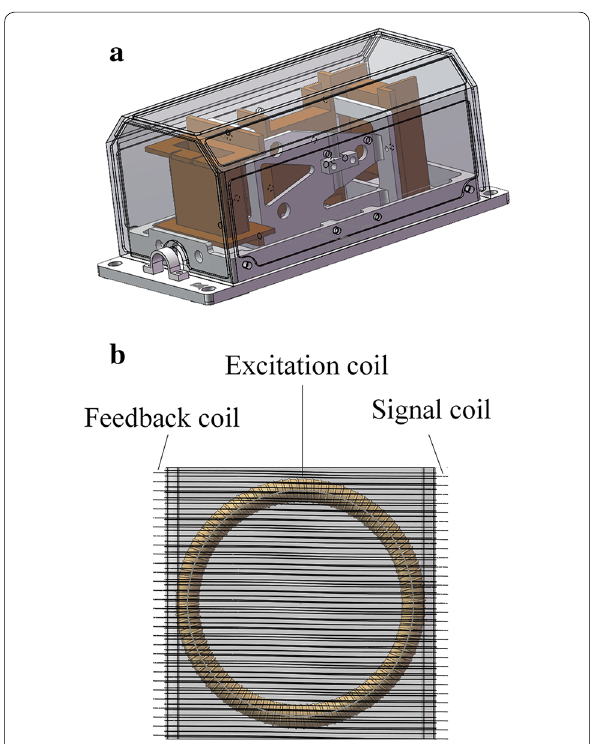
Fig. 3 FGM sensor configuration. a FGM sensor consists of three orthogonal components (shown as brown units); b each component consists of three coils: excitation coil, feedback coil, and signal